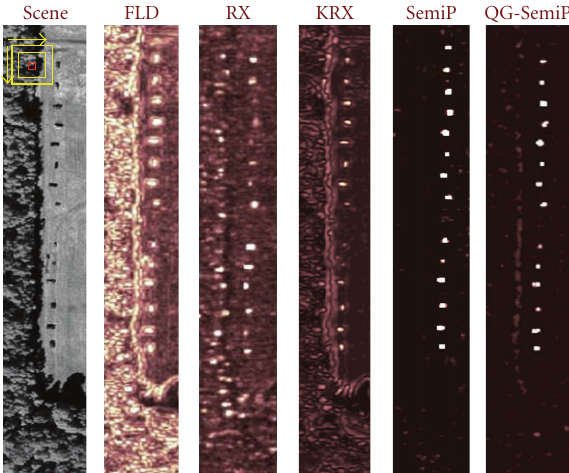
Figure 16: Detection algorithms’ output surfaces for Cube 1 (far left). The intensity of local peaks reflects the strength of evidences as seen by di ff erent anomaly detection approaches. Boundary issues were ignored in this test; surfaces were magnified to about the size of the original image only for the purpose of visual comparison. FLD, RX, KRX, and SemiP performed local anomaly detection by testing spectra within a testing window (red square shown in the scene display—far left, top) to spectra surrounding the testing window (outer window bounded by yellow lines). QG-SemiP performed global anomaly detection, as presented in this